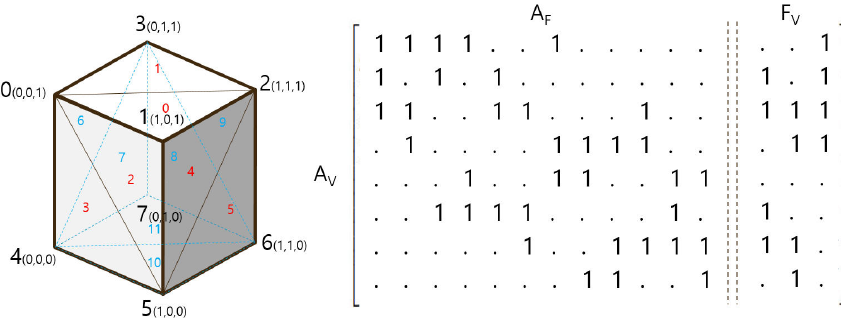
Figure 4. Vertex-face adjacency ( A VF ) and vertex feature ( F V ) of a simple cube.